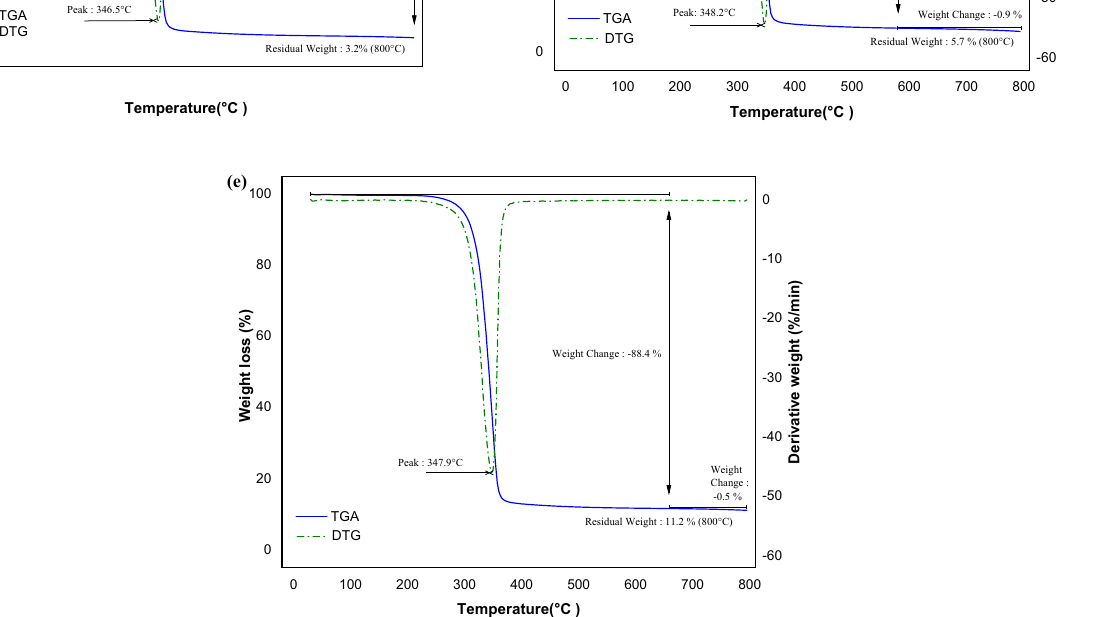
Figure 5: TGA and DTG analysis of ( a ) PLA CONTROL , ( b ) PLA/CNF - PP 5 , ( c ) PLA/CNF - PP 10 , ( d ) PLA/CNF - PP 15 , and ( e ) PLA/CNF - PP 20